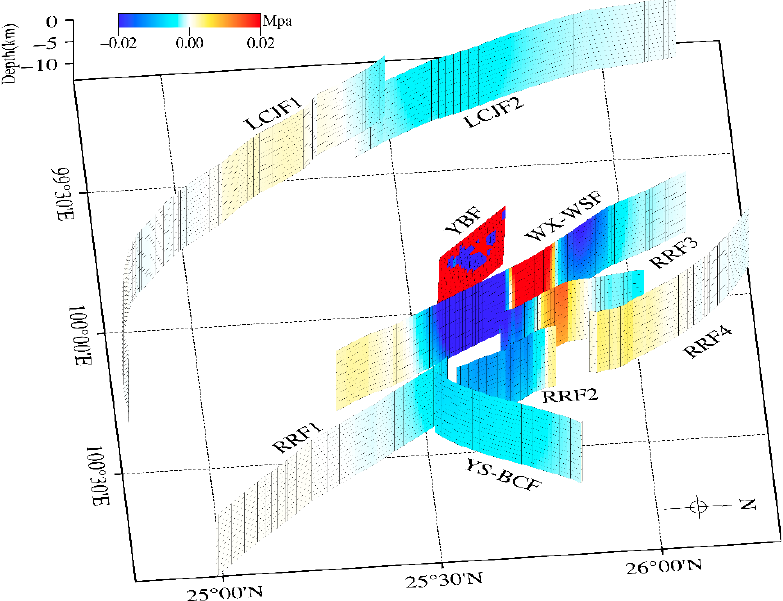
Figure 13. Coseismic Coulomb stress changes on the surrounding faults caused by the 2021 Yangbi earthquake. The magenta star denotes the location of the mainshock. YBF = Yangbi Fault, WX-WSF = Weixi-Weishan Fault; RRF 1–4 = Red River Fault 1–4; YS-BCF = Yongsheng-Binchuan Fault; LCJF 1–2 = Lancangjiang Fault 1–2.